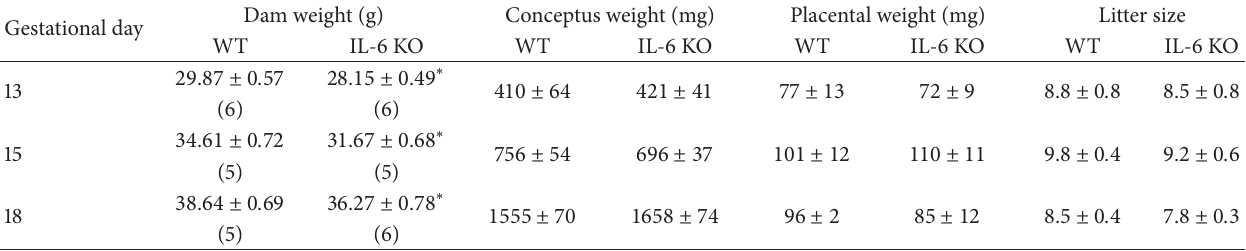
Table 1: Litter size, weights of dams, conceptuses, and placentas in WT and IL-6 KO dams.